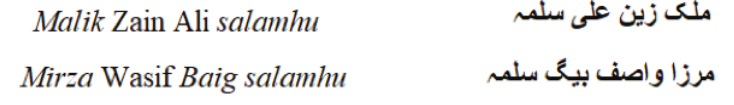
Figure 4: The naming convention of the